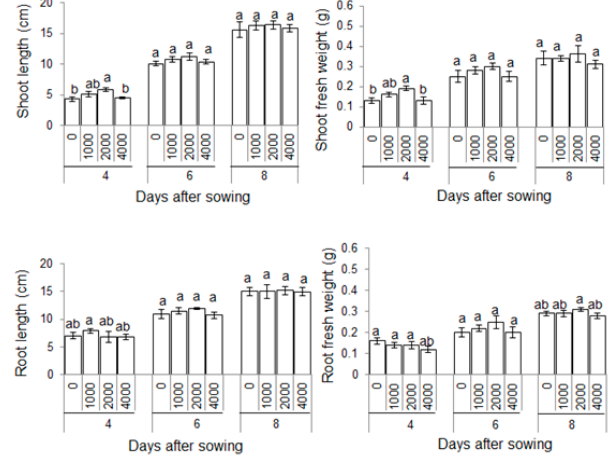
Figure 3. Morphological changes in maize treated with plant-derived smoke. Maize seeds were soaked without or with 1000 ppm, 2000 ppm, and 4000 ppm plant-derived smoke for 6 h and sown in sand for 4, 6, and 8 days. The length and fresh weight of shoot and root were measured. The data are shown as means ± S.D. from 4 independent biological replicates. Different letters indicate that the change is significant as determined by one-way ANOVA followed by Tukey’s multiple comparison ( p ˂ 0.05).